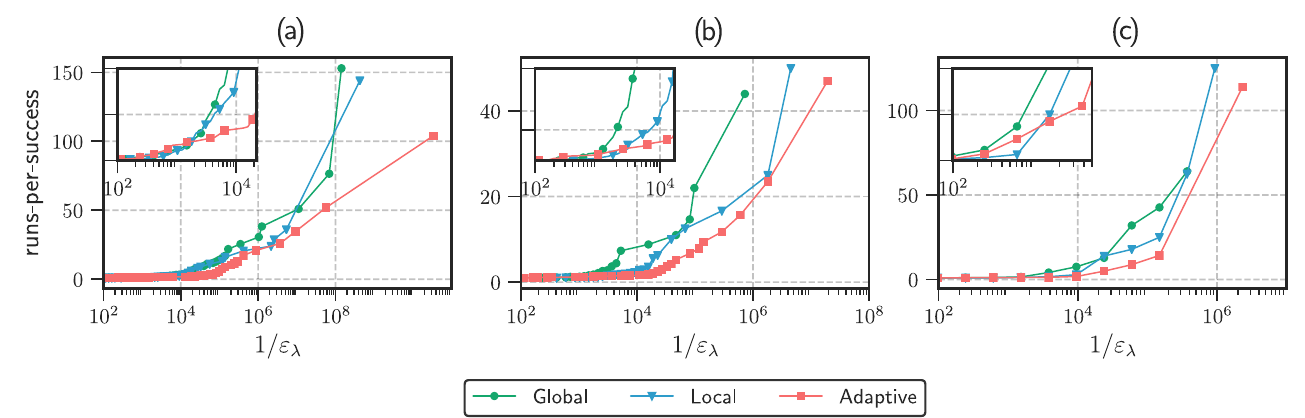
Fig. 5 Runs-per-success versus inverse absolute error 1/ ε λ . We implemented VQSE for the states of: a n = 6, b n = 8, and c n = 10 qubits corresponding to Fig. 4. The insets depict the same data in the small 1/ ε λ regime. Runs-per-success is de fi ned as the total number of runs divided by the number of runs with a relative error smaller than a target ε λ . For all three cases, we can see that as 1/ ε λ increases, the adaptive Hamiltonian has the lowest number of runs-per-success, and hence the best performance. In all cases, the x -axis is plotted on a log scale.